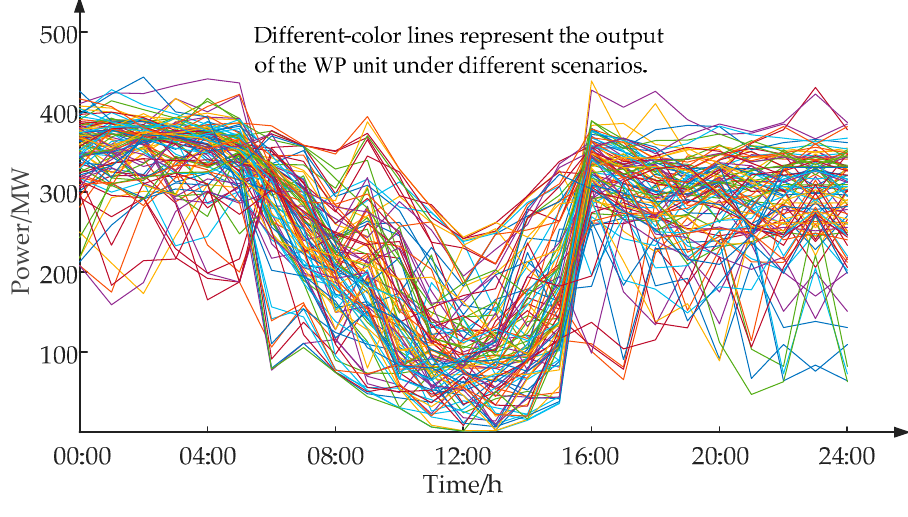
Figure 6. Day-ahead wind power forecast scenario set.